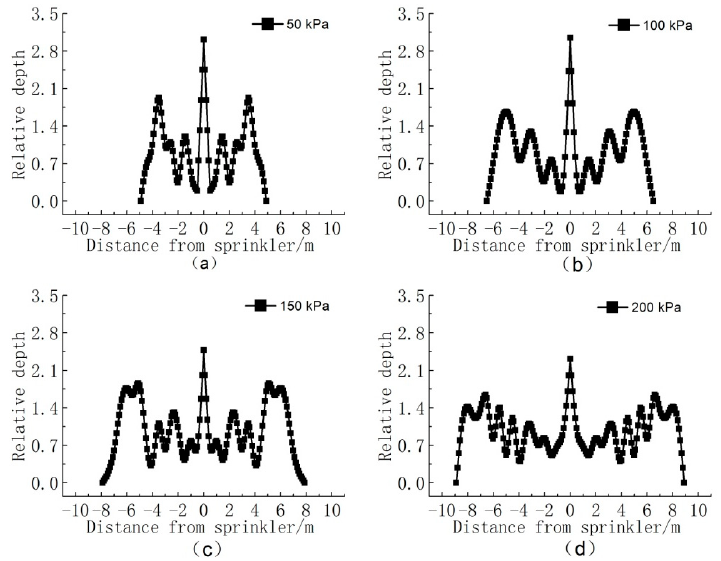
Table 4. Comparison of measured and calculated jet distances for different working pressures.